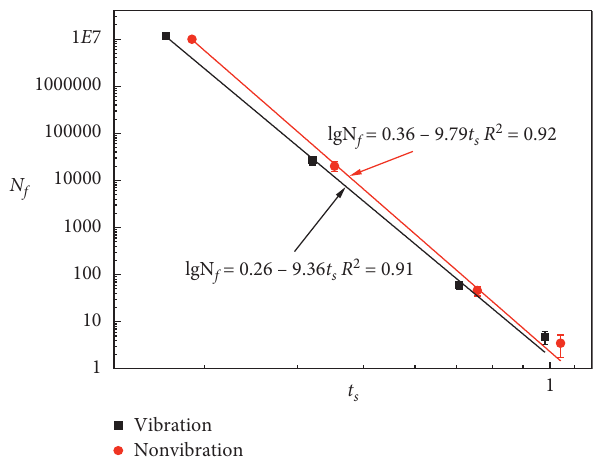
Figure 13: Indirect tensile fatigue curve based on real stress ratio of specimens prepared by different mixing techniques.